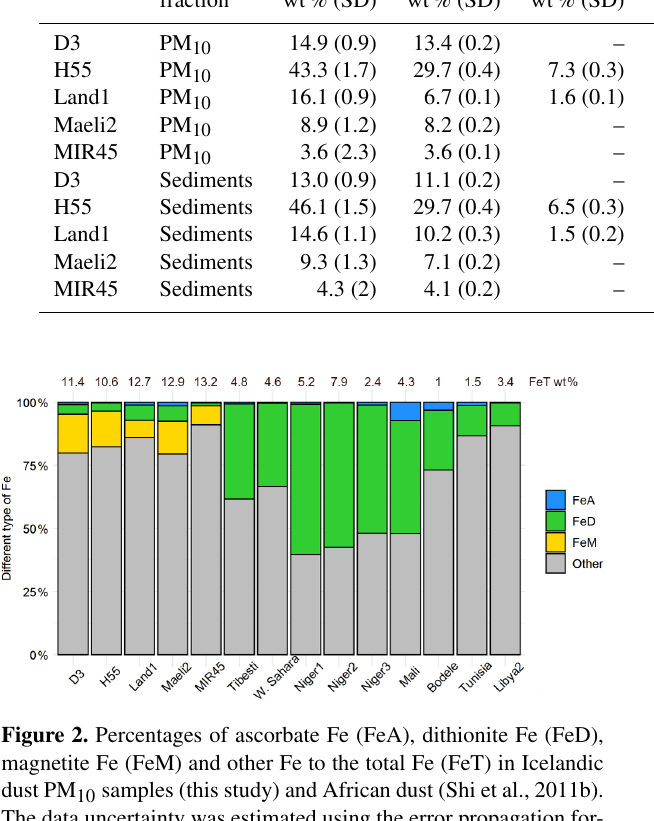
Table 2. Mineralogical composition of PM 10 and sediments. Standard deviation (SD) values of the identified mineral phases are estimated by the MAUD software, except for anorthite, which is calculated using the error propagation formula. Samples